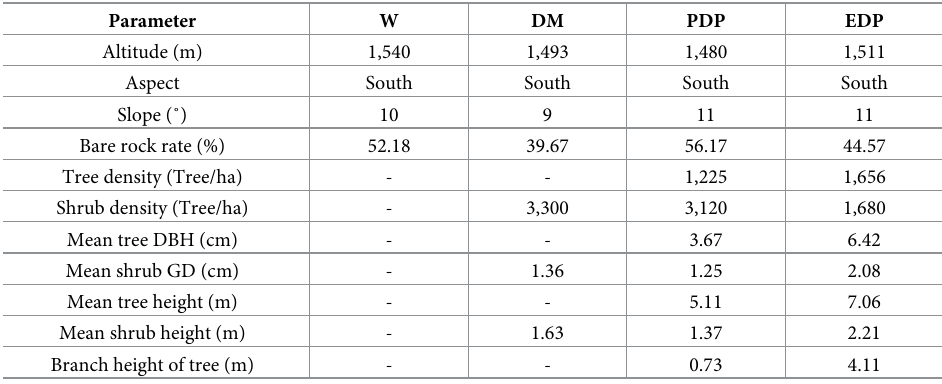
DBH: diameter at breast height; GD: ground diameter; and Branch height of tree: the height from ground level to